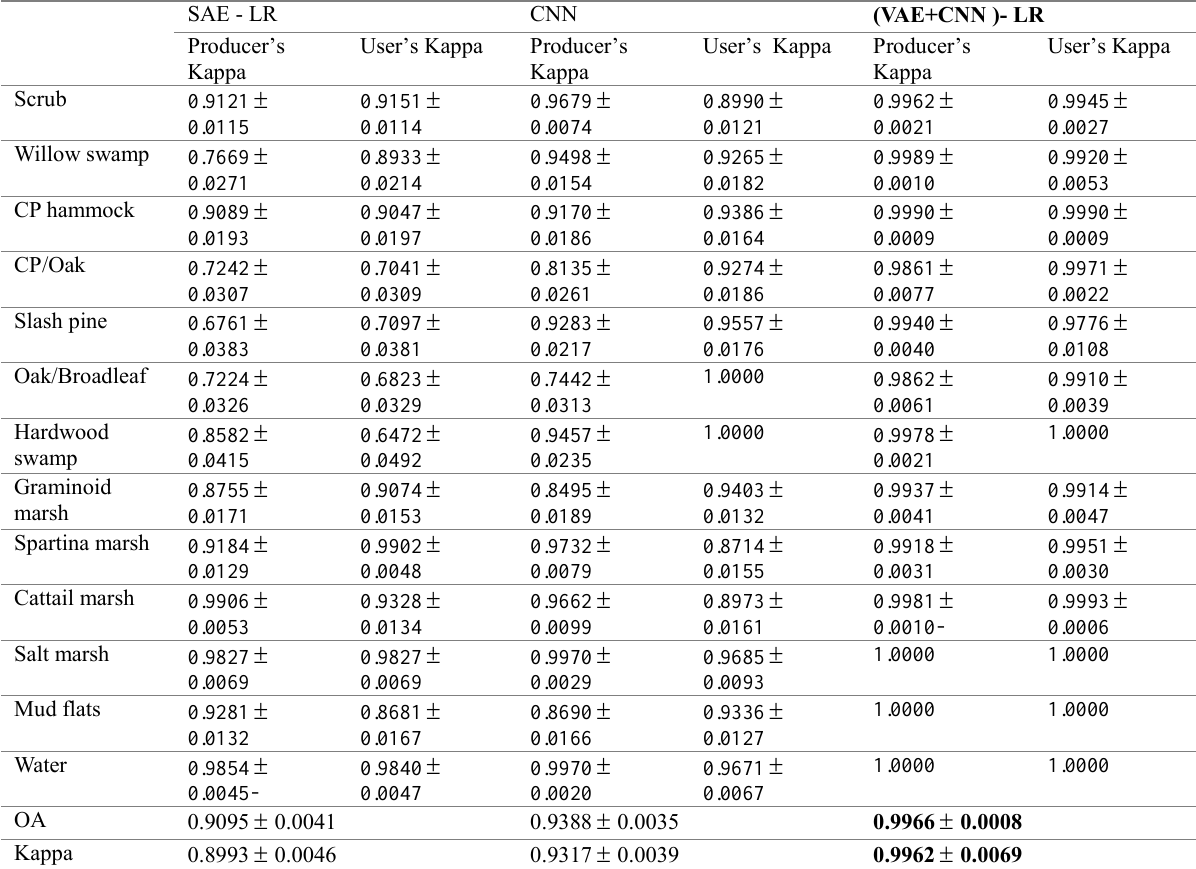
Table 1. Class-wise accuracies of the Kennedy Space Centre (KSC) image